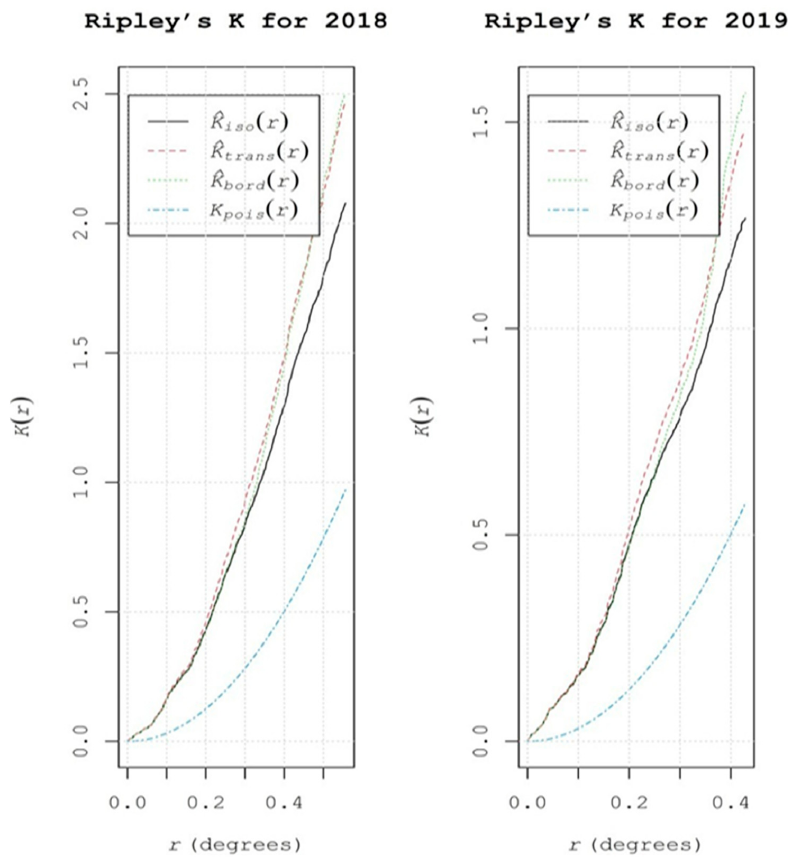
Figure 4. Ripley’s K function values for different sampling sites, showing the explicit spatial pat- terns of FRD in Karnataka during 2018 and